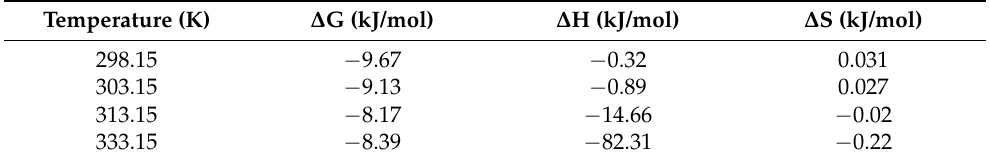
Table 3. Thermodynamic parameters for alizarin extraction in an aqueous media utilizing DES-3.